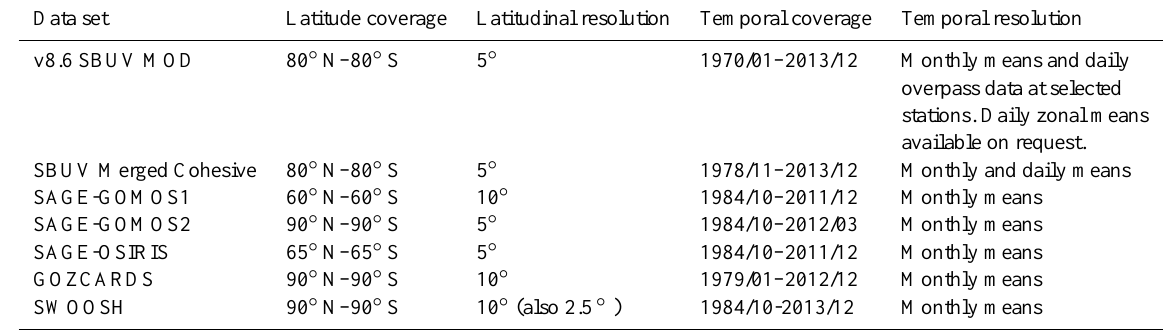
Table 1. Summary of the latitudinal coverage and resolution as well as the temporal coverage and resolution of each of the seven data sets. Data set